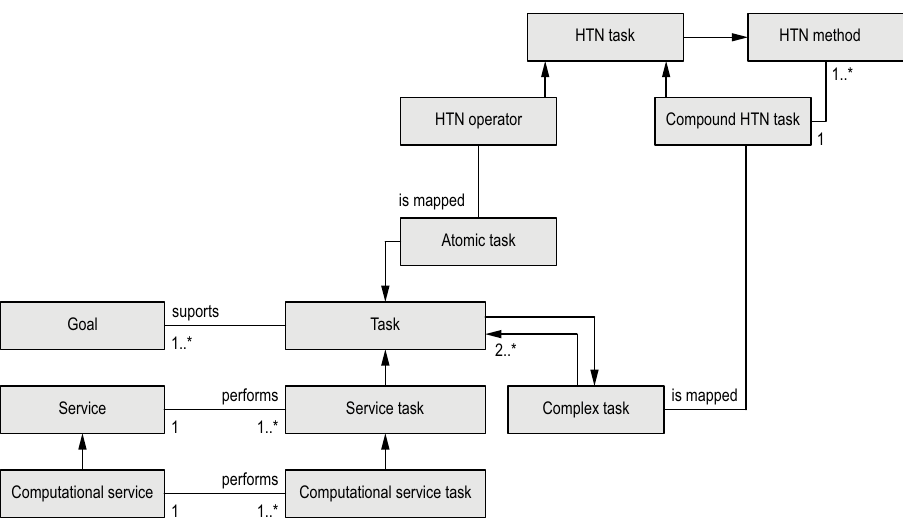
Fig. 3. Task decomposition and the relationship to goals and